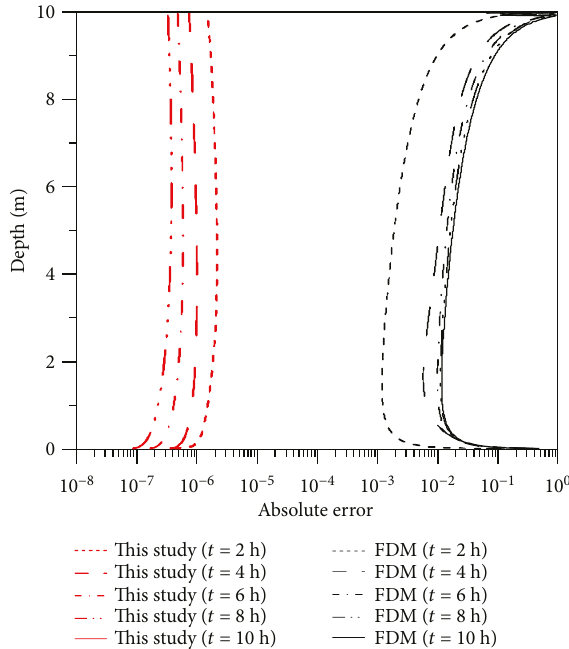
Figure 4: Comparison of the absolute error of the computed results and the FDM.